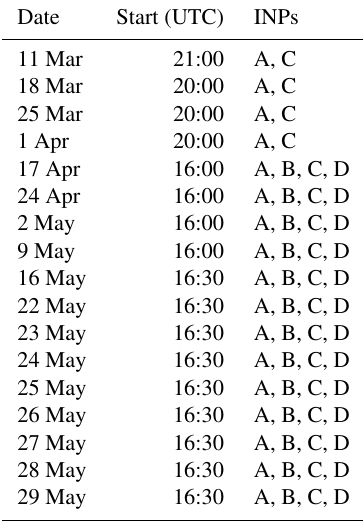
Table 1. Dates and start times of sample collection during IN- POP (2017) for samples analyzed for INPs. Samples correspond to 1 full day (24h from the start time). The “INPs” column corre- sponds to the stages that were analyzed via the DFCP per daily sam- ple. A = 2.96–>12µm, B = 1.21–2.96µm, C = 0.34–1.21µm, and D =